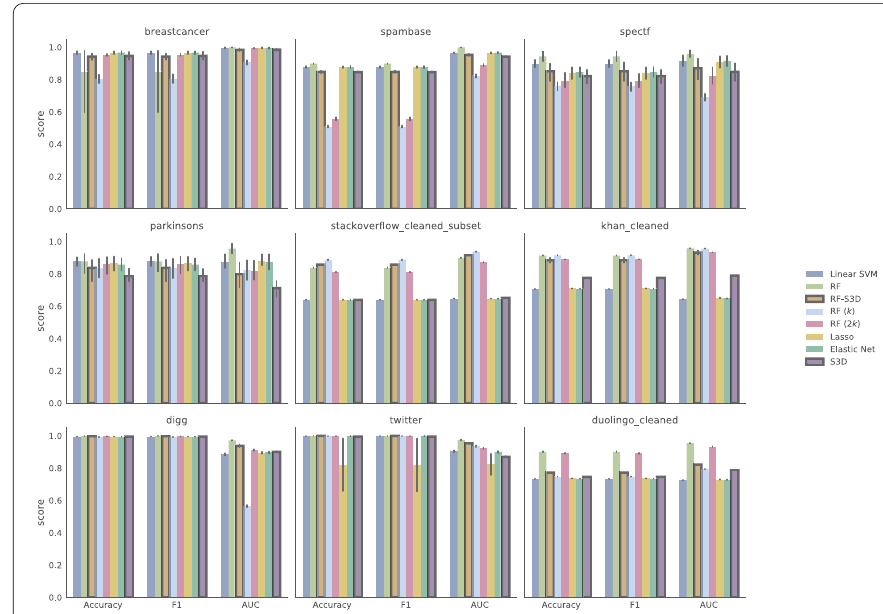
Figure 3 Classification performance on 5-fold cross validation in nine datasets. Error bars here indicate one standard deviation. A higher bar (greater value) means better performance